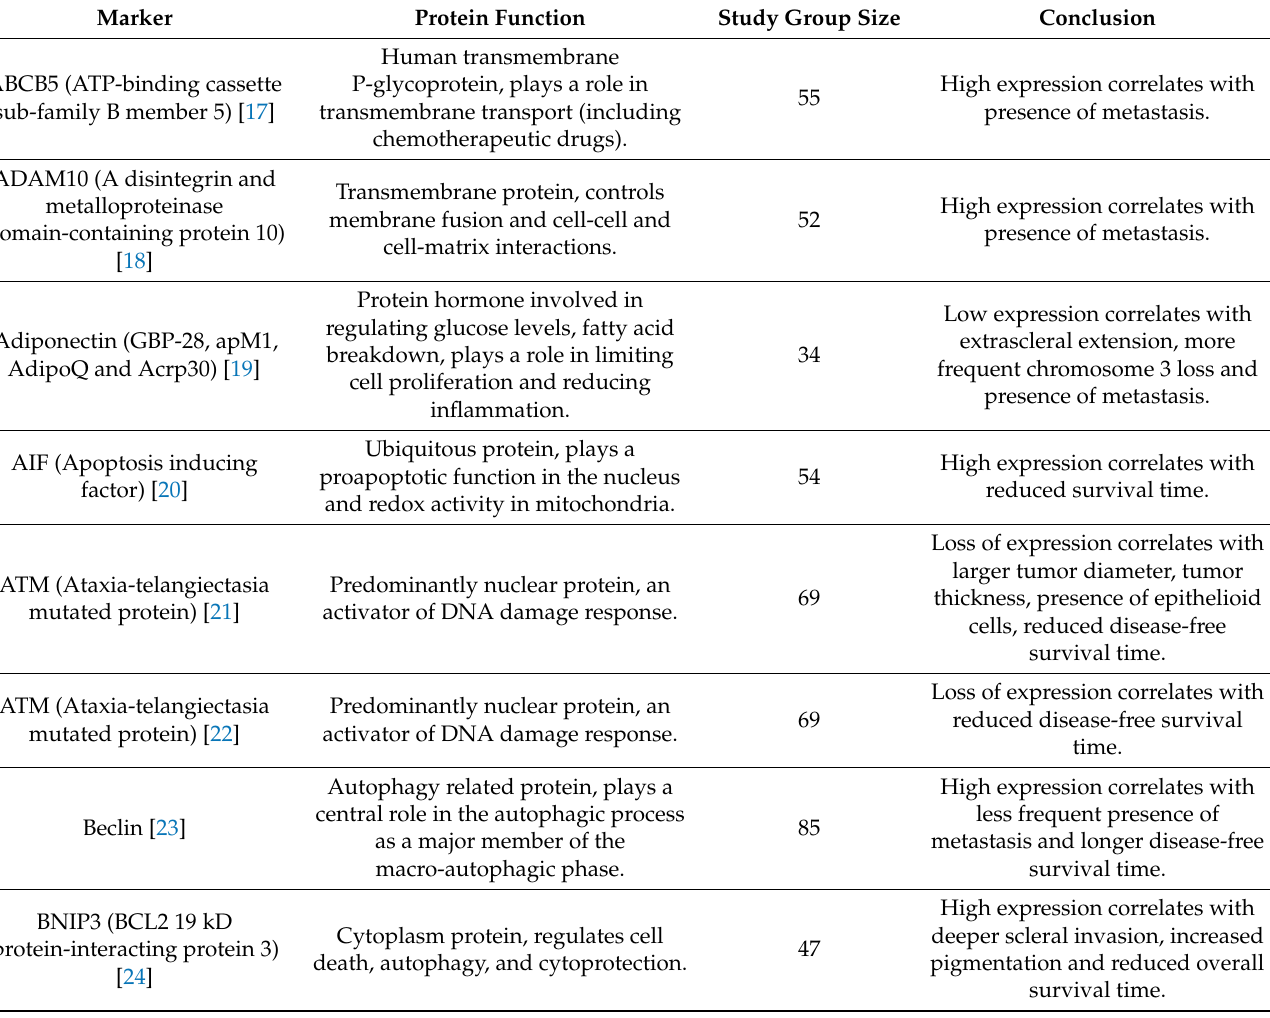
Table 1. Summary of all markers whose expression is related to different prognostic factors in uveal melanoma. Marker Protein Function Study Group Size